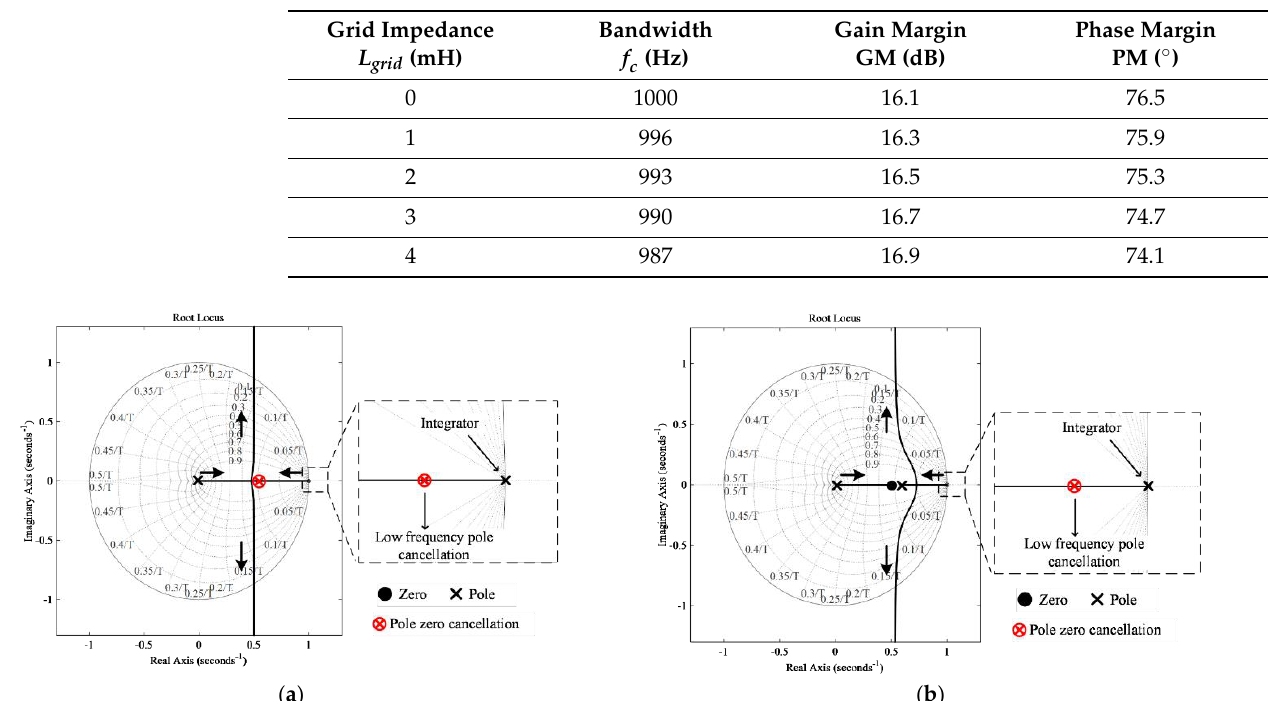
Table 6. Stability Analysis of RESO Based ADRC for the L Filter Type GcI.